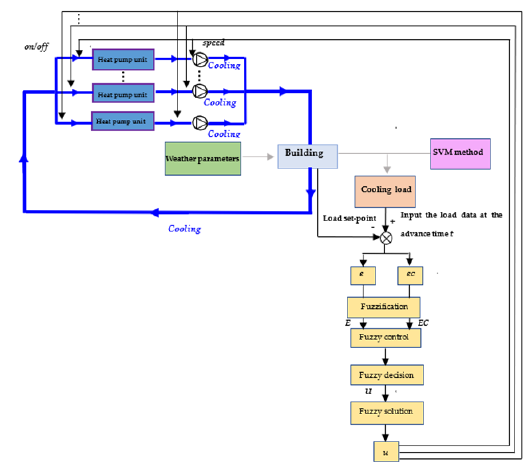
Figure 4. The logic diagram of the load forecast fuzzy (LFF) control strategy.